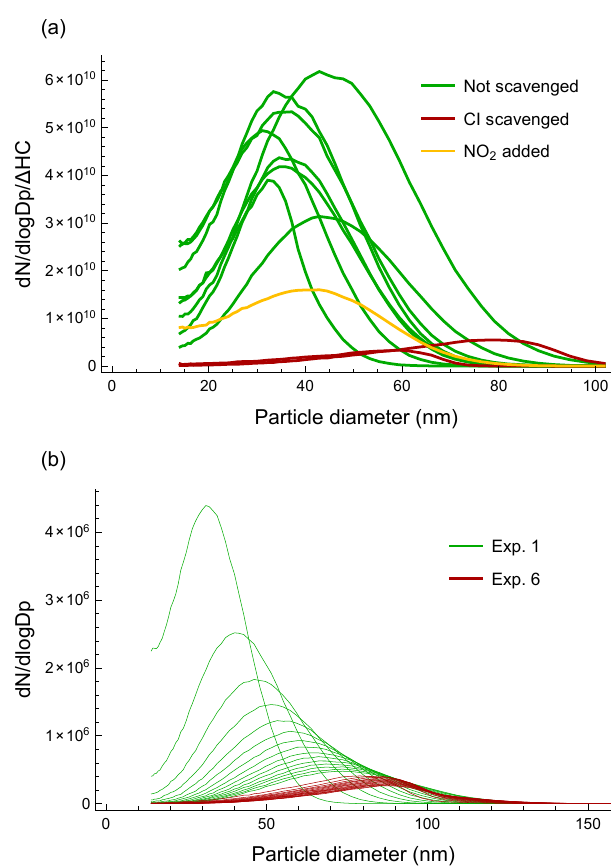
Figure 11. Impact of sCI scavengers on particle nucleation shown by (a) peak particle number distributions scaled for the amount of α -phellandrene reacted in all experiments and (b) particle number distributions evolution over the first hour of experiments 1 and 6.